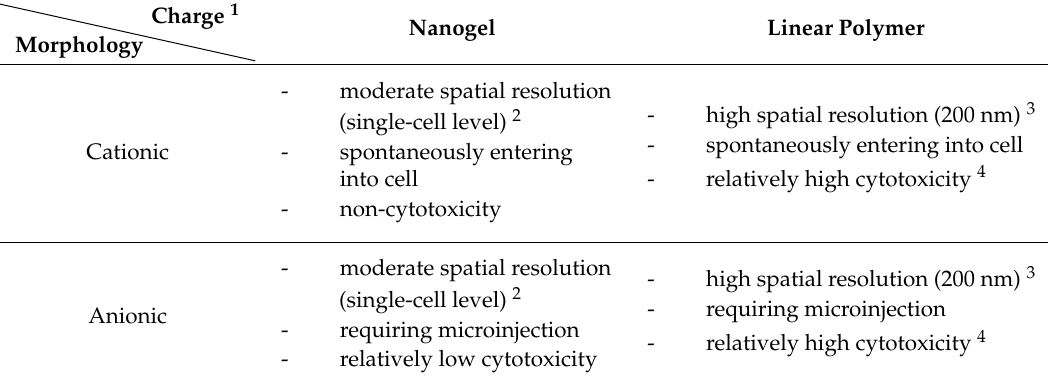
Table 3. Comparison of fluorescent polymeric thermometers for intracellular thermometry.